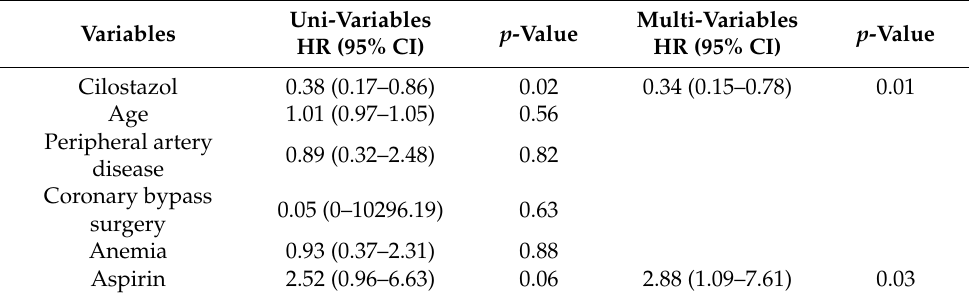
Table 3. Uni- and multi-variables independently predicting major coronary events.